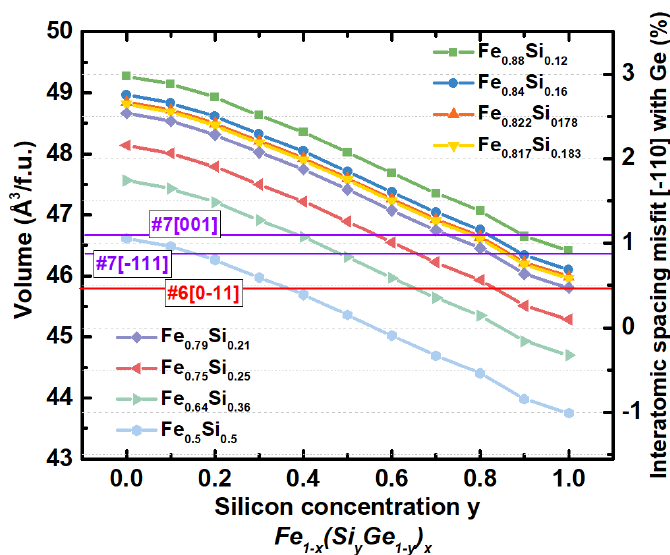
Figure 4. Dependence of unit cell volume per functional unit of ternary Fe–Ge–Si alloys.